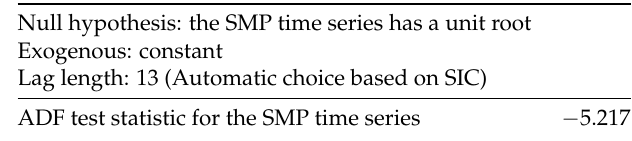
Table A1. ADF test for the SMP time series.